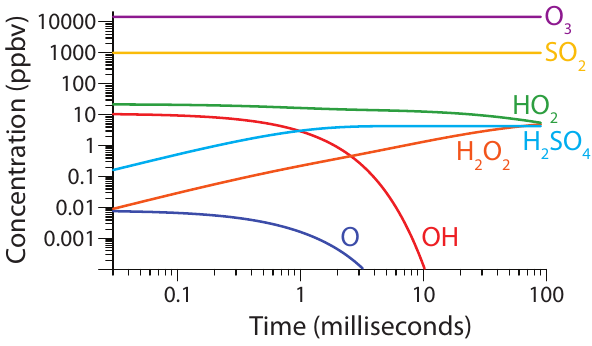
Fig. 8. Facsimile model of potential oxidants and H 2 SO 4 produced as 11ppbv OH is generated from the photolysis of water in 20 % oxygen and mixed with 1ppm SO 2 at atmospheric pressure.